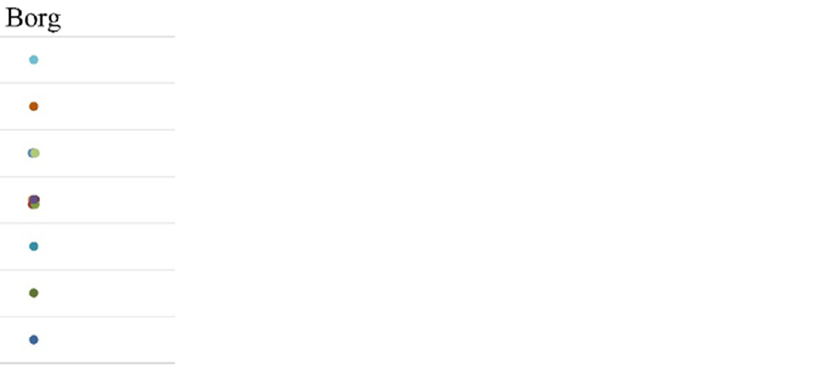
Figure 7. The Borg scale scores after the first LEX exercise. LEX, leg exercise apparatus. Regarding the secondary outcome, no DVT of the lower extremities was confirmed dur- ing the first postoperative week. The average preoperative D-dimer level was 0.85 µ g/mL (range, 0.4–2.2), whereas the corresponding value on the first postoperative week was 7.93 µ g/mL (range,